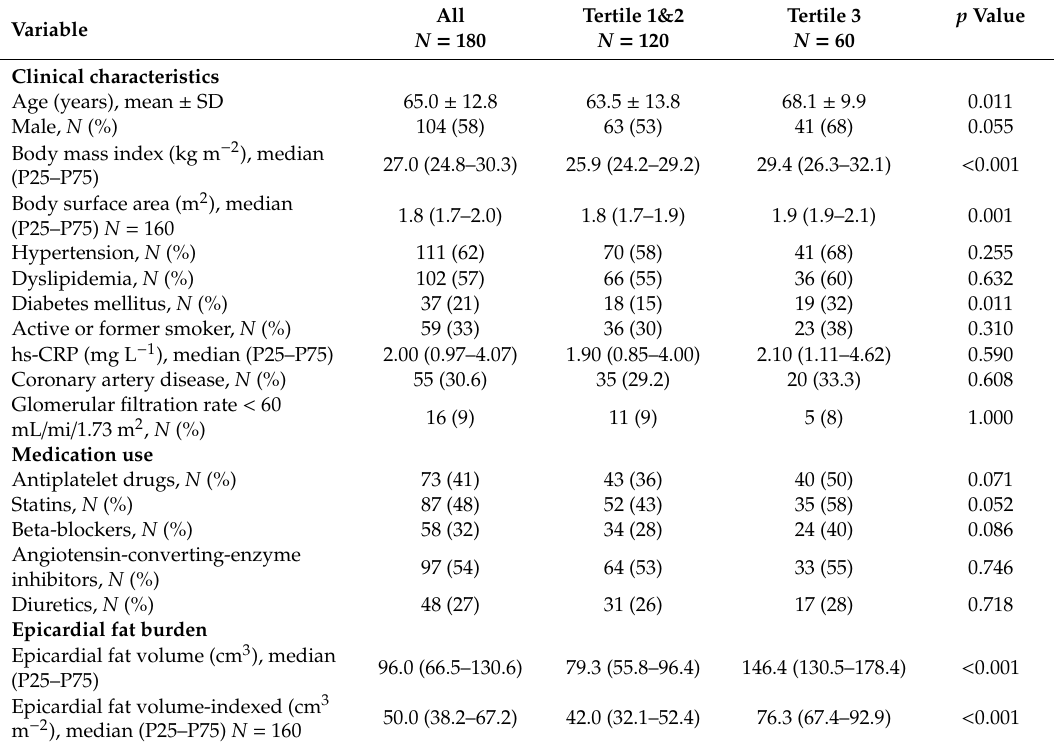
Table 1. Characteristics of the study